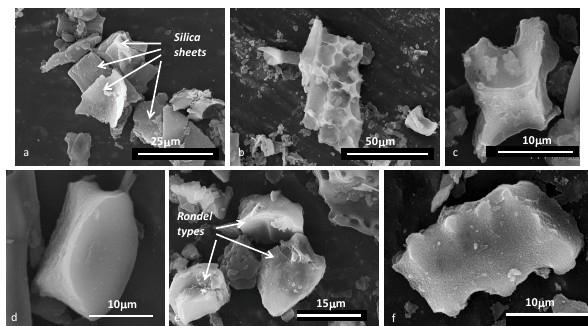
Figure 1. SEM images of TD-F-L wheat phytolith assemblage, de- posited on an aluminum mount. Three categories are illustrated: (1) silica sheets (a, b) , (2) stellate type from intercellular space (c) and (3) GSC phytoliths including rondel (d, e) and polylobate types (f) .